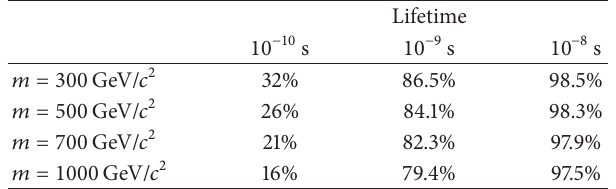
Figure 6: Velocity distribution of pair-produced heavy quarks in units of 𝛽 = V /𝑐 as predicted by MadGraph. Table 7: Fraction of rejected decays of heavy quarks outside of the geometrical acceptance of 4 cm around the primary interaction vertex for three different lifetimes and four different heavy quark